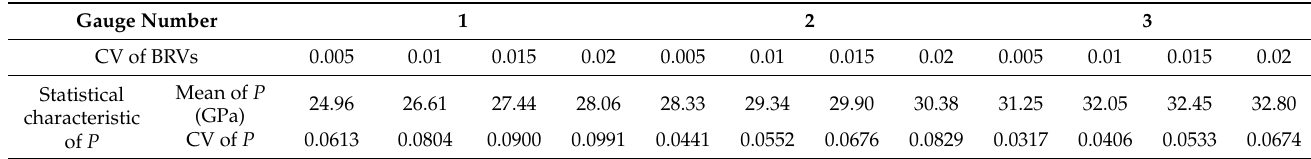
Table 13. The calculation results of the GABP-MCS in the DPR study under the shock load condition where v is 1000